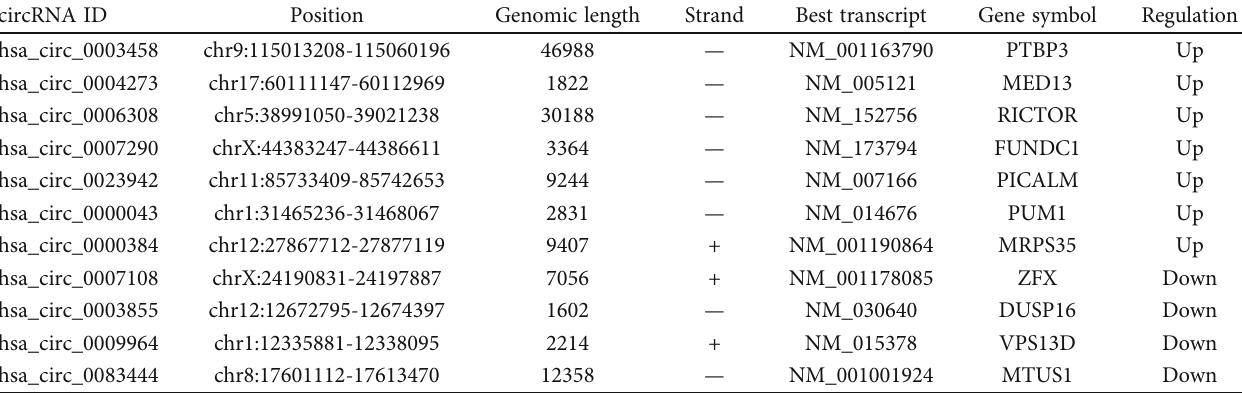
Table 1: The basic characteristics of 11 DEcircRNAs between cancerous tissues and noncancerous gastric tissues. circRNA ID Position Genomic length Strand Best transcript Gene